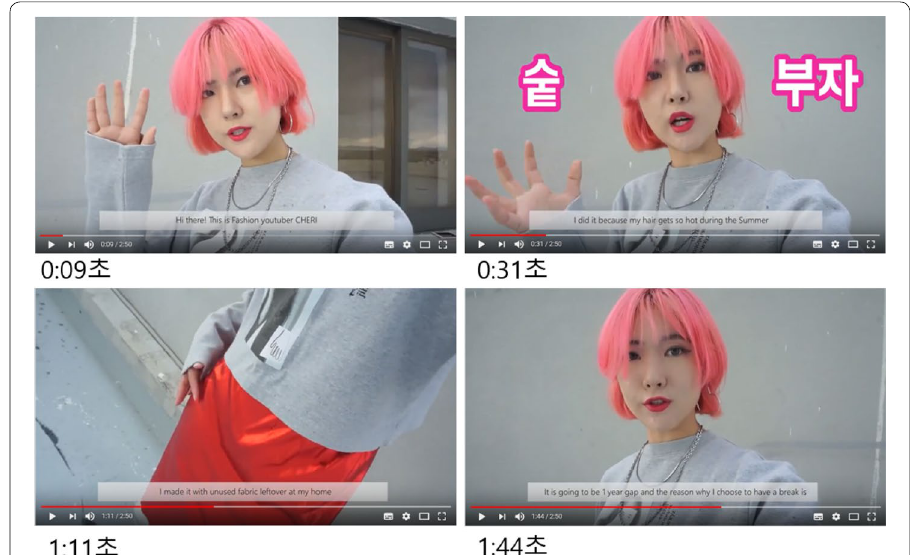
Fig. 2 <Vlog-implicit exposure type> (The source of the video: https ://www.youtu be.com/watch ?v m5wsW 8&t =